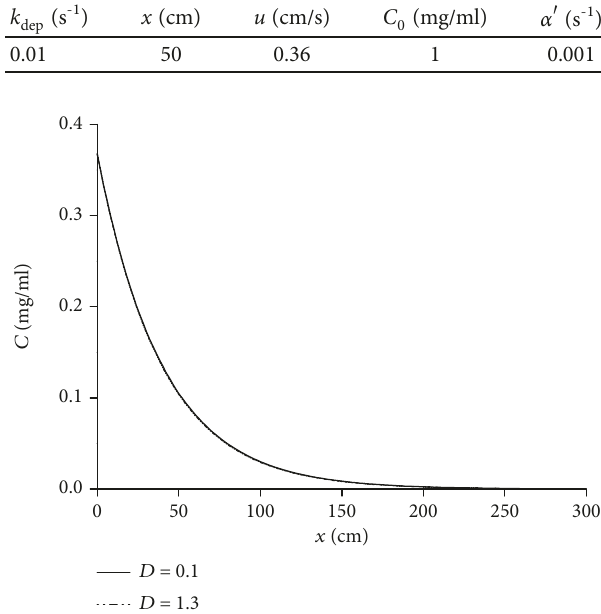
Figure 3: Relationship between particle concentration and time for two dispersion coe ffi cients, using parameters given in Table 2. Table 2: Model parameters used for simulations shown in Figure 3.